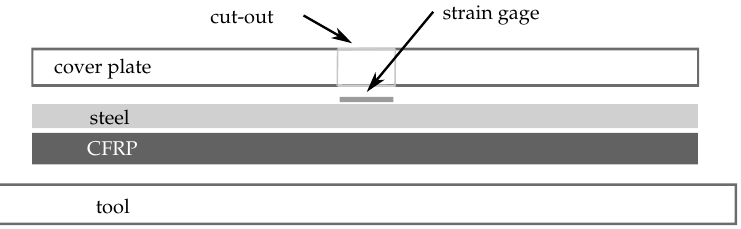
Figure 7. Manufacturing setup for specimen equipped with strain